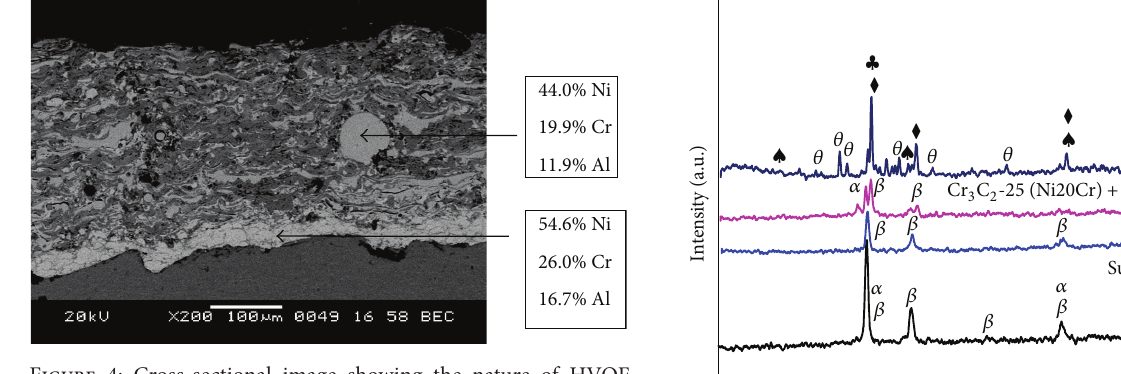
Figure 4: Cross-sectional image showing the nature of HVOF sprayed coatings.